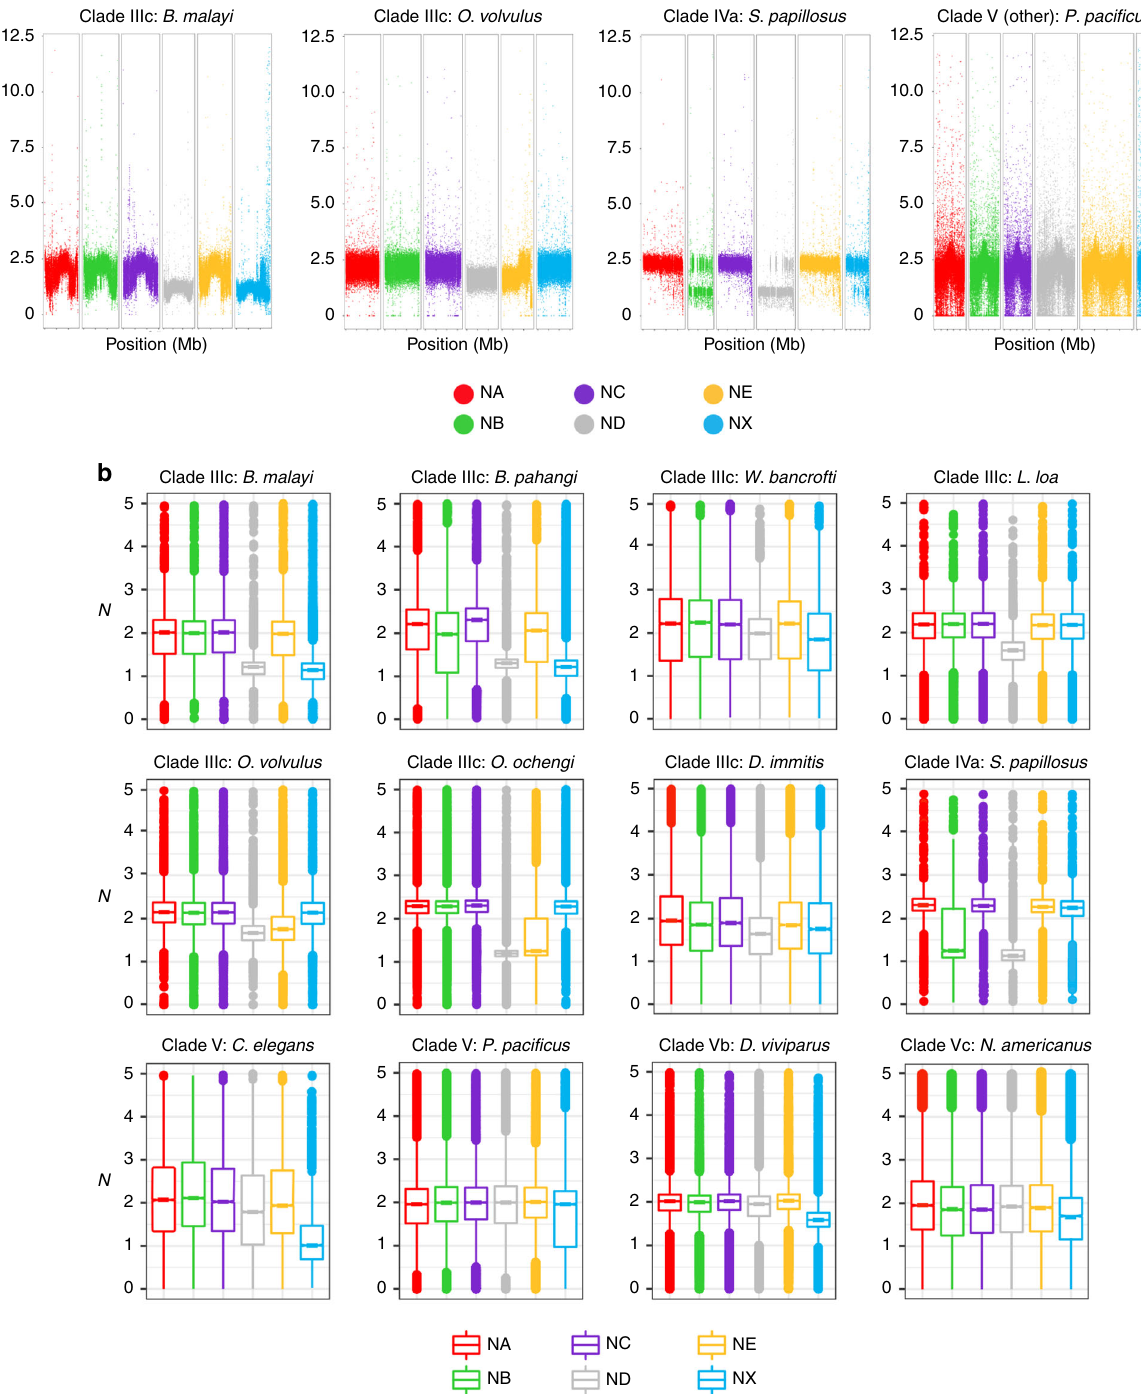
Fig. 3 Sequencing depth per Nigon element for diverse nematodes. We provide examples of species across clade III, IV, and V nematodes. a The calculated N (average sequencing depth over a 10 kb window normalized to half the average sequencing depth of the whole diploid genome) is visualized for each of the Nigon elements for a representative set of species in different clades. Haploid regions are likely contiguous, but not visualized as such in these plots since data is plotted by the contig order in the reference genome. On the X- axis, distances between ticks represent 5 Mb. b Box plots showing the calculated N according to Nigon element reveals that B. malayi , B. pahangi , and W. bancrofti all share similar unpaired chromosome segments in males corresponding to ND and NX. L. loa appears to only be unpaired in males for ND, while O. volvulus and O. ochengi are unpaired in males for ND and NE. D. viviparus and N. americanus are unpaired in males for only NX, while P. paci fi cus is only partially unpaired in males for NX, as expected and previously described. The center line of the box plots is drawn at the median of the depth at each Nigon element, the upper and lower hinges are at the 25% and 75% quartiles of the depth, while the whiskers extend 1.5× the interquartile range. Outliers are plotted as points outside of that